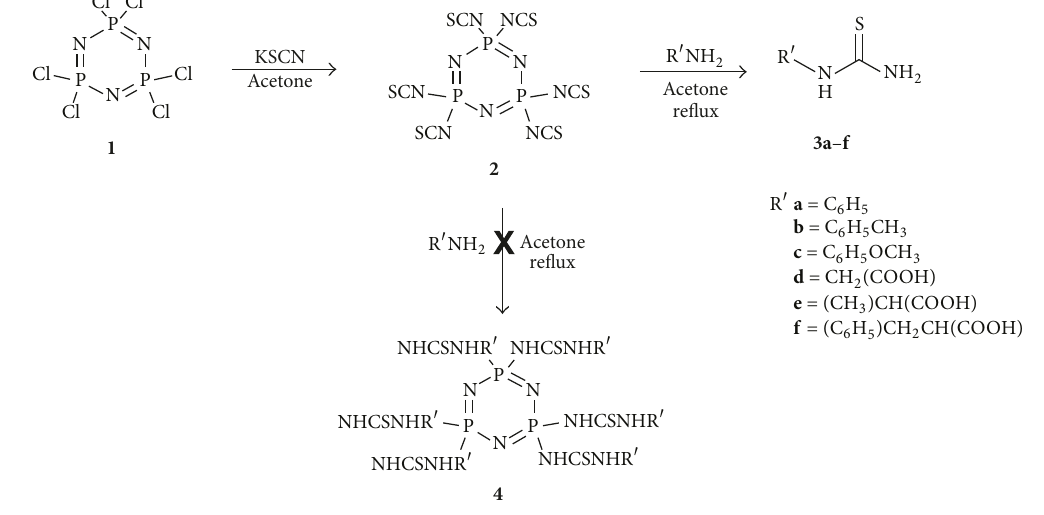
Scheme 1: The synthesis of 3a – f